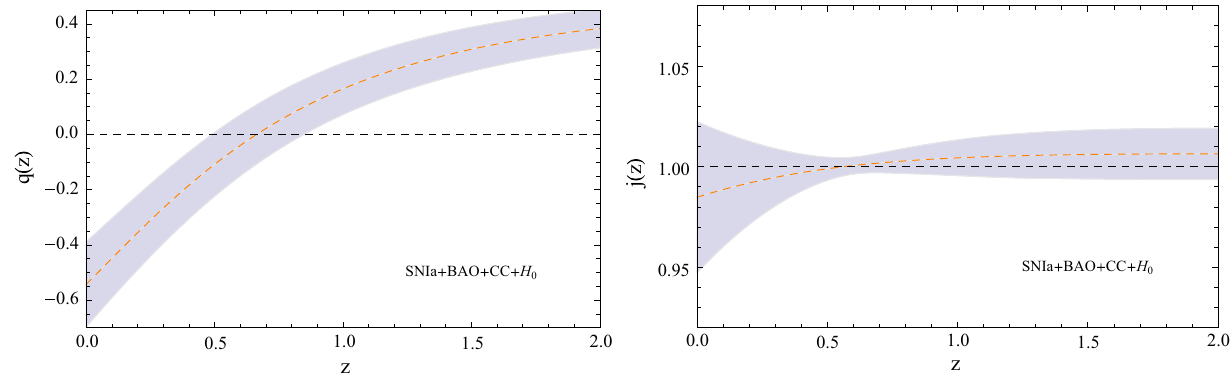
Fig. 3 Reconstruction of the q ( z ) (deceleration parameter) and j ( z ) (jerk parameter) from SN Ia + BAO + CC + H 0 data set at 1 σ CL